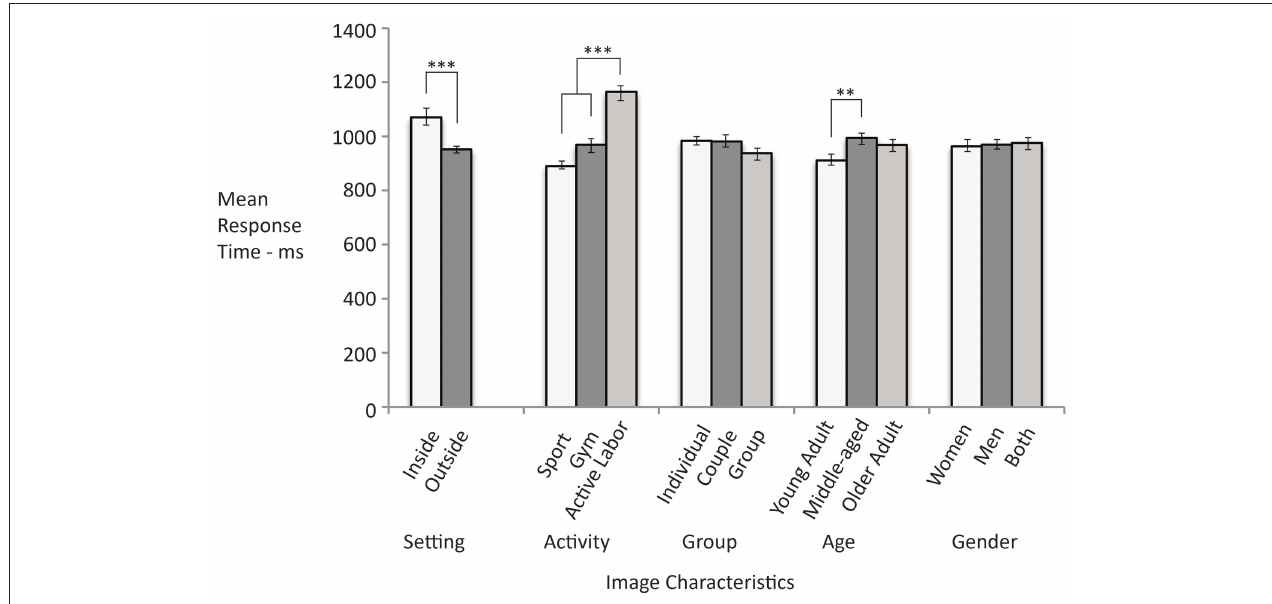
FIGURE 1 | Faster response time indicates stronger automatic associations of the images with exercise. Significant differences are noted with asterisks. Error bars reflect standard errors.